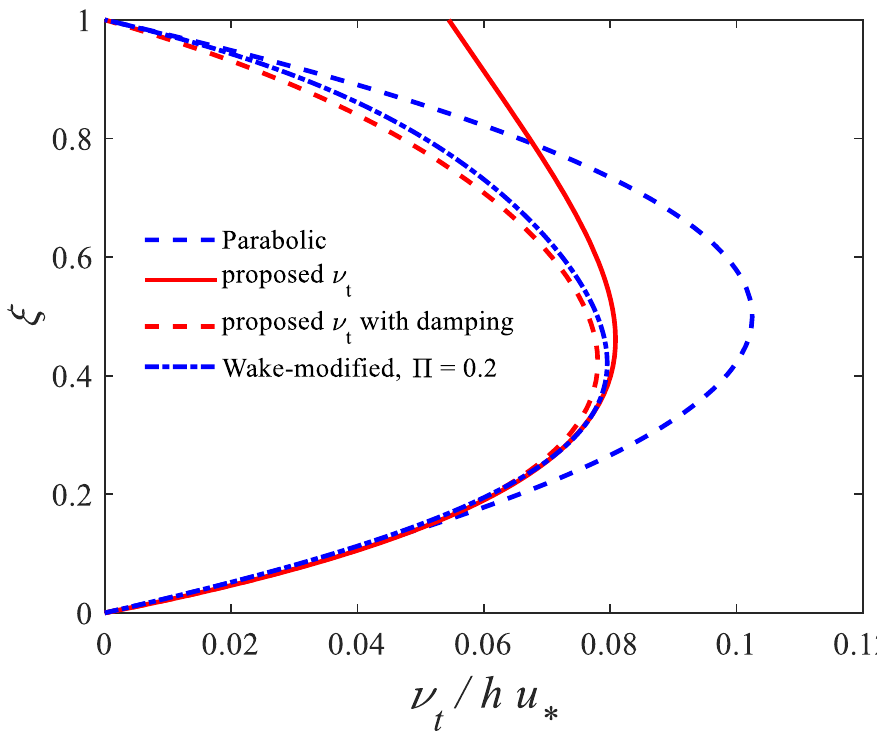
Figure 1. Eddy viscosity profiles; red solid line: eddy viscosity (5) with C α = 0.477 and C 1 = 2.17 ; red dashed line: eddy viscosity with free surface damping function (6) with B f = 6 ; blue dash-dotted line: log-wake- modified with Π=0.2; blue dashed line: parabolic eddy viscosity.